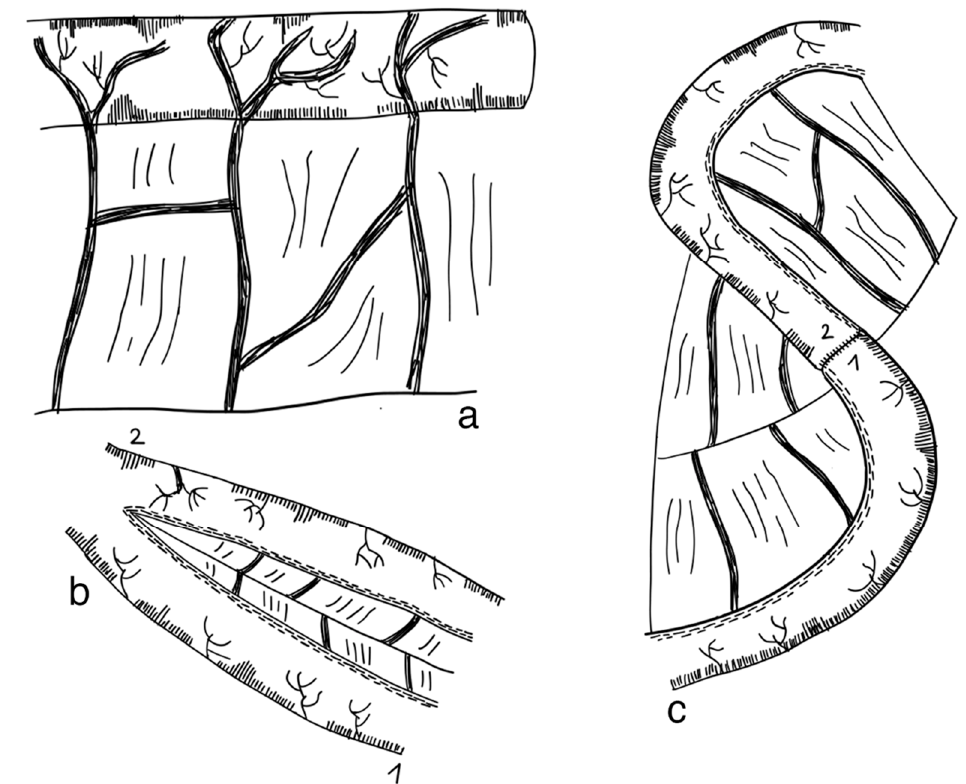
Figure 3. ( a ) A section of the dilated small intestine (view from the side) ( b ) is divided longitudinally into two intestinal halves (view from above). ( c ) These parts are then fashioned together into two narrower tubes. Numbers 1–2 illustrate the movement and new placement of the two intestinal halves. Bianchi [100].